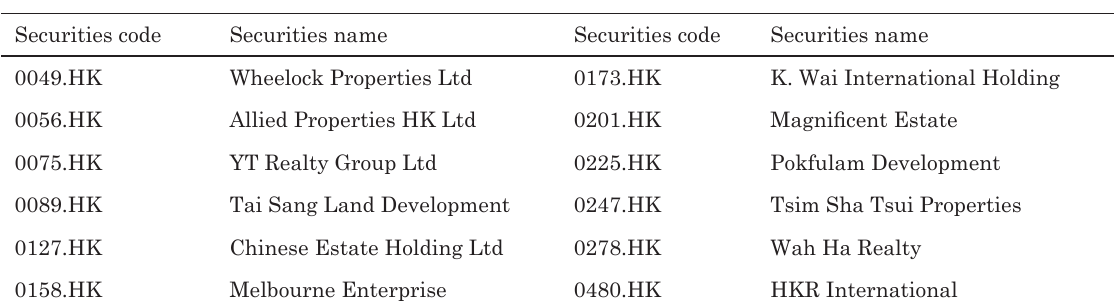
table 2. normal real estate